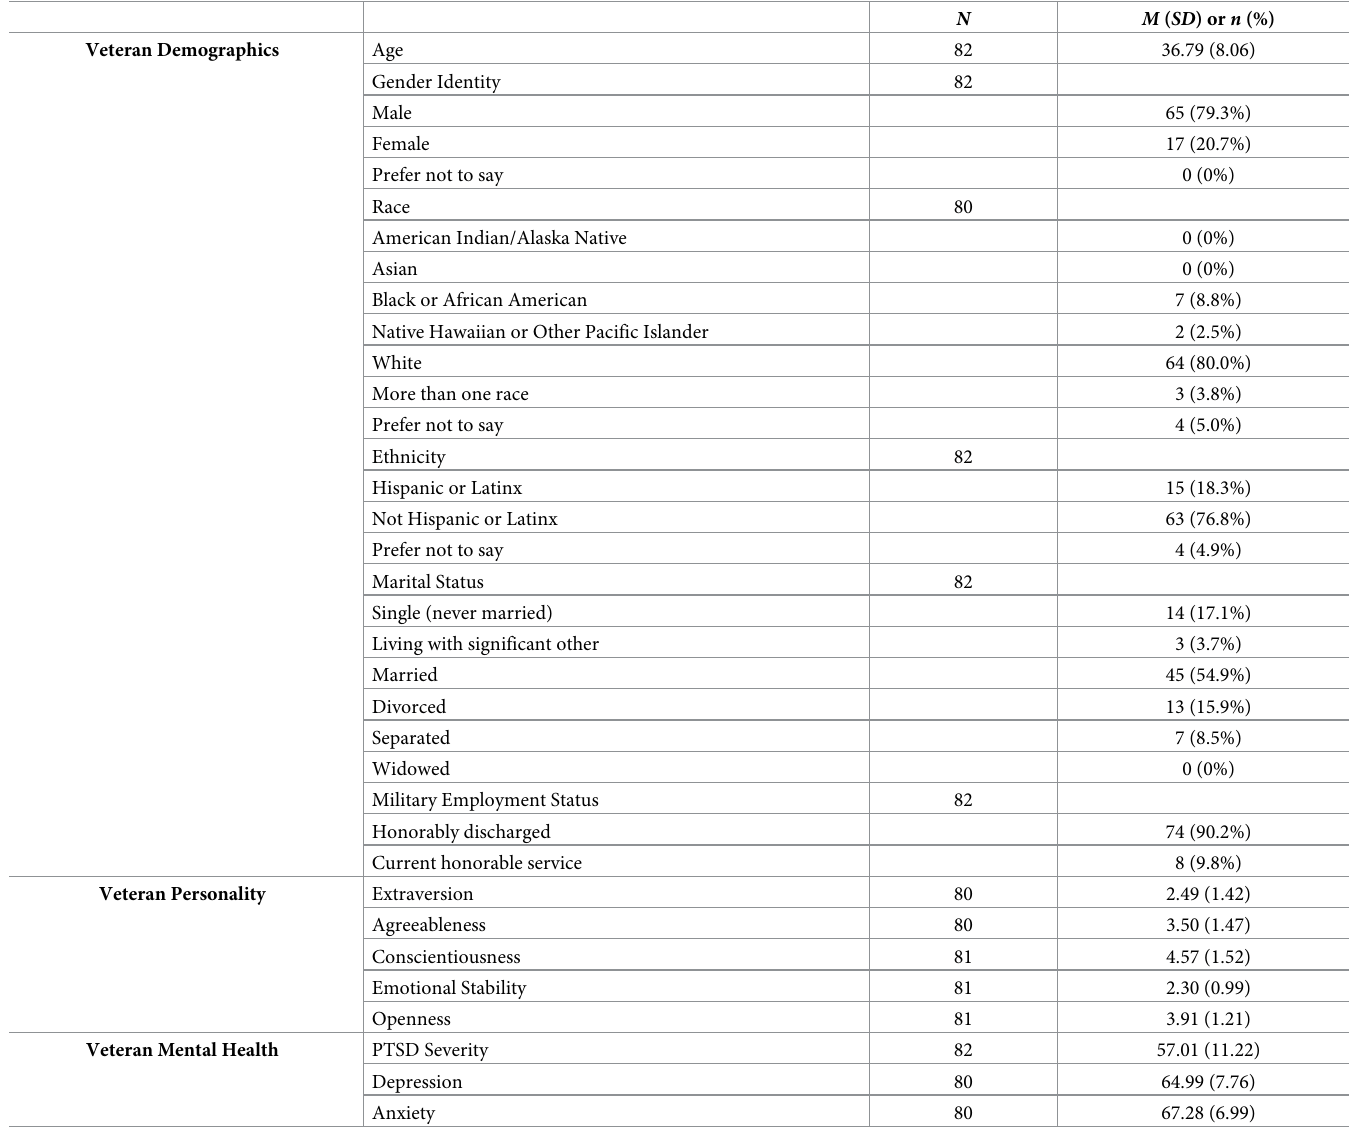
Table 2. Veteran demographic characteristics, personality, and mental health at baseline.